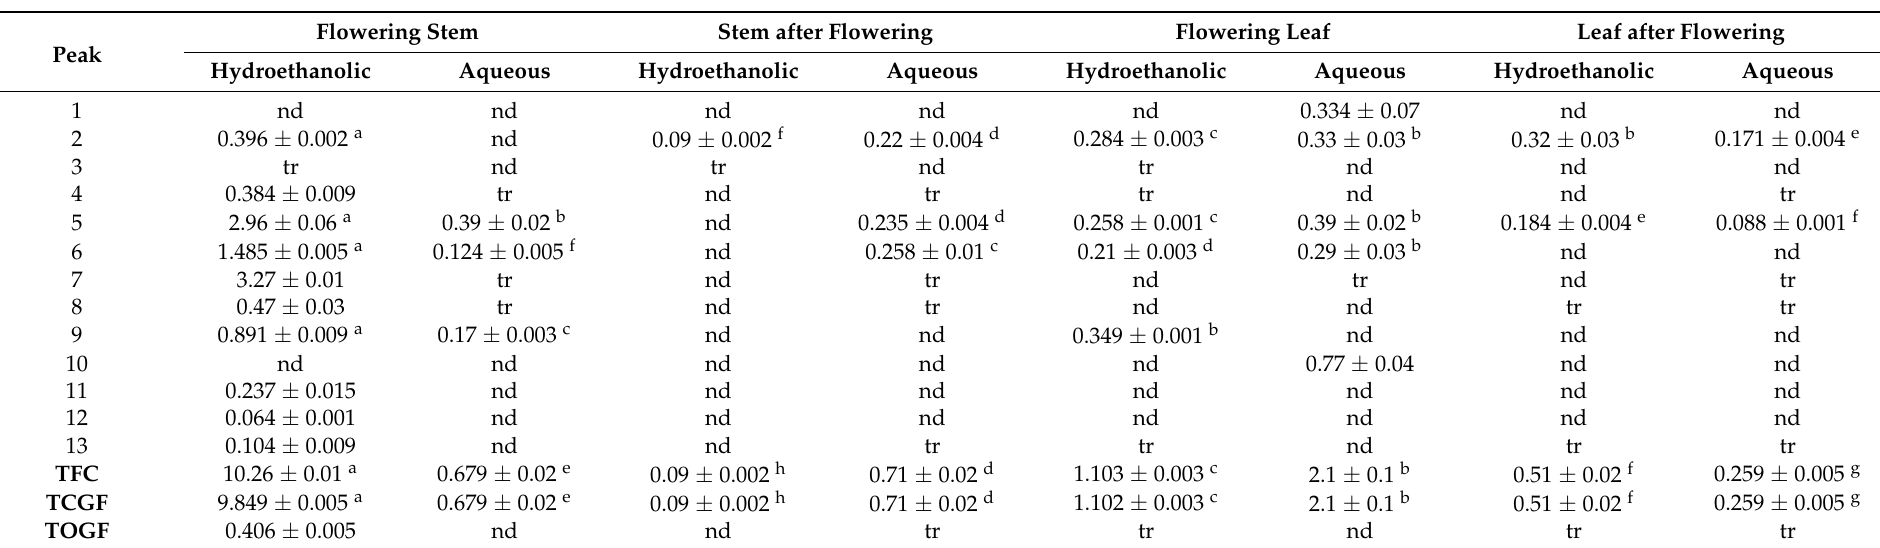
Table 4. Quantification (mg/g extract) of the phenolic compounds-glycosylated and O -glycosylated flavonoids present in the hydroethanolic and aqueous extracts of C. erecta (mean ± SD, n =